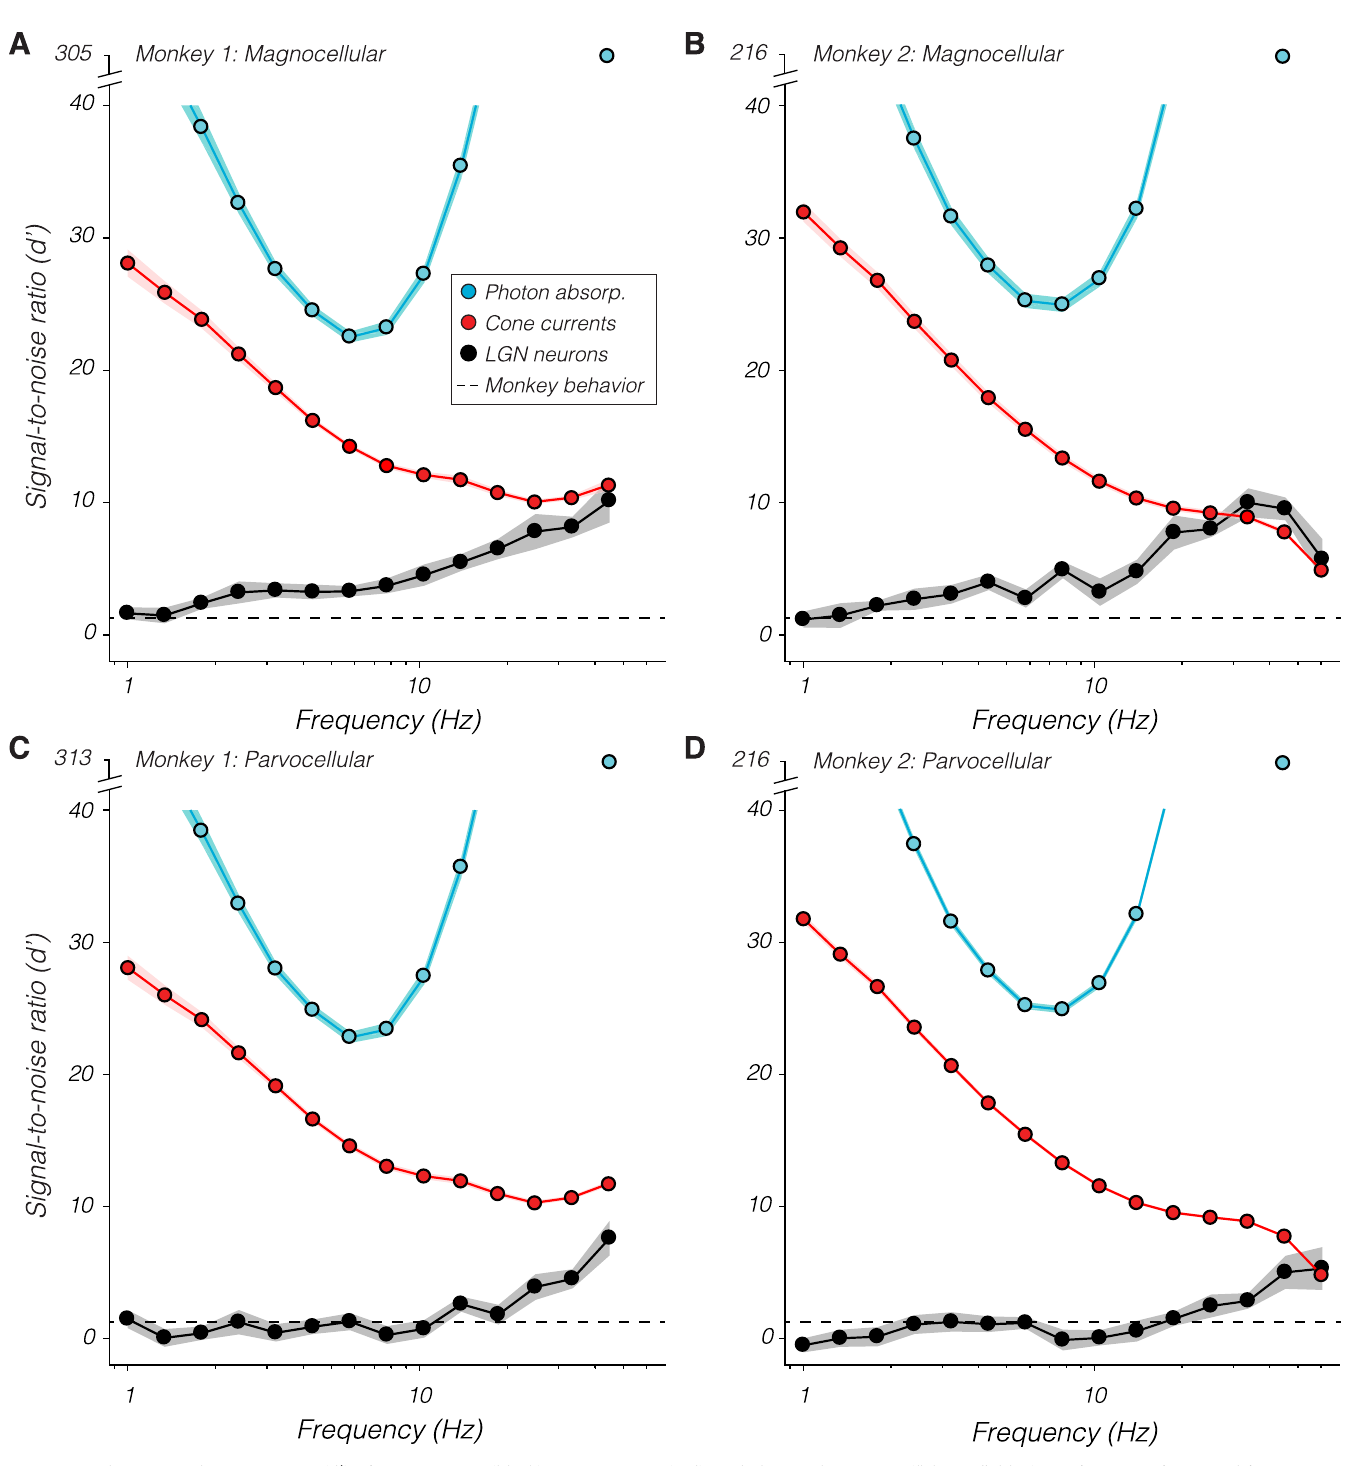
Fig 5. Population signal-to-noise ratio (d 0 ) of LGN neurons (black), cone currents (red), and photon absorptions (“absorp.”; blue) as a function of temporal frequency. Points are means and bands are ± 1 standard error. The monkeys’ psychophysical d 0 for all stimuli is approximately 1.27 (dashed line). Note the break in the ordinate needed to show the d 0 of the photon absorption ideal observer at 45 Hz. Data are available at https://github.com/horwitzlab/LGN-temporal-contrast-sensitivity/blob/ master/DataByFigure.xlsx. LGN, lateral geniculate nucleus.